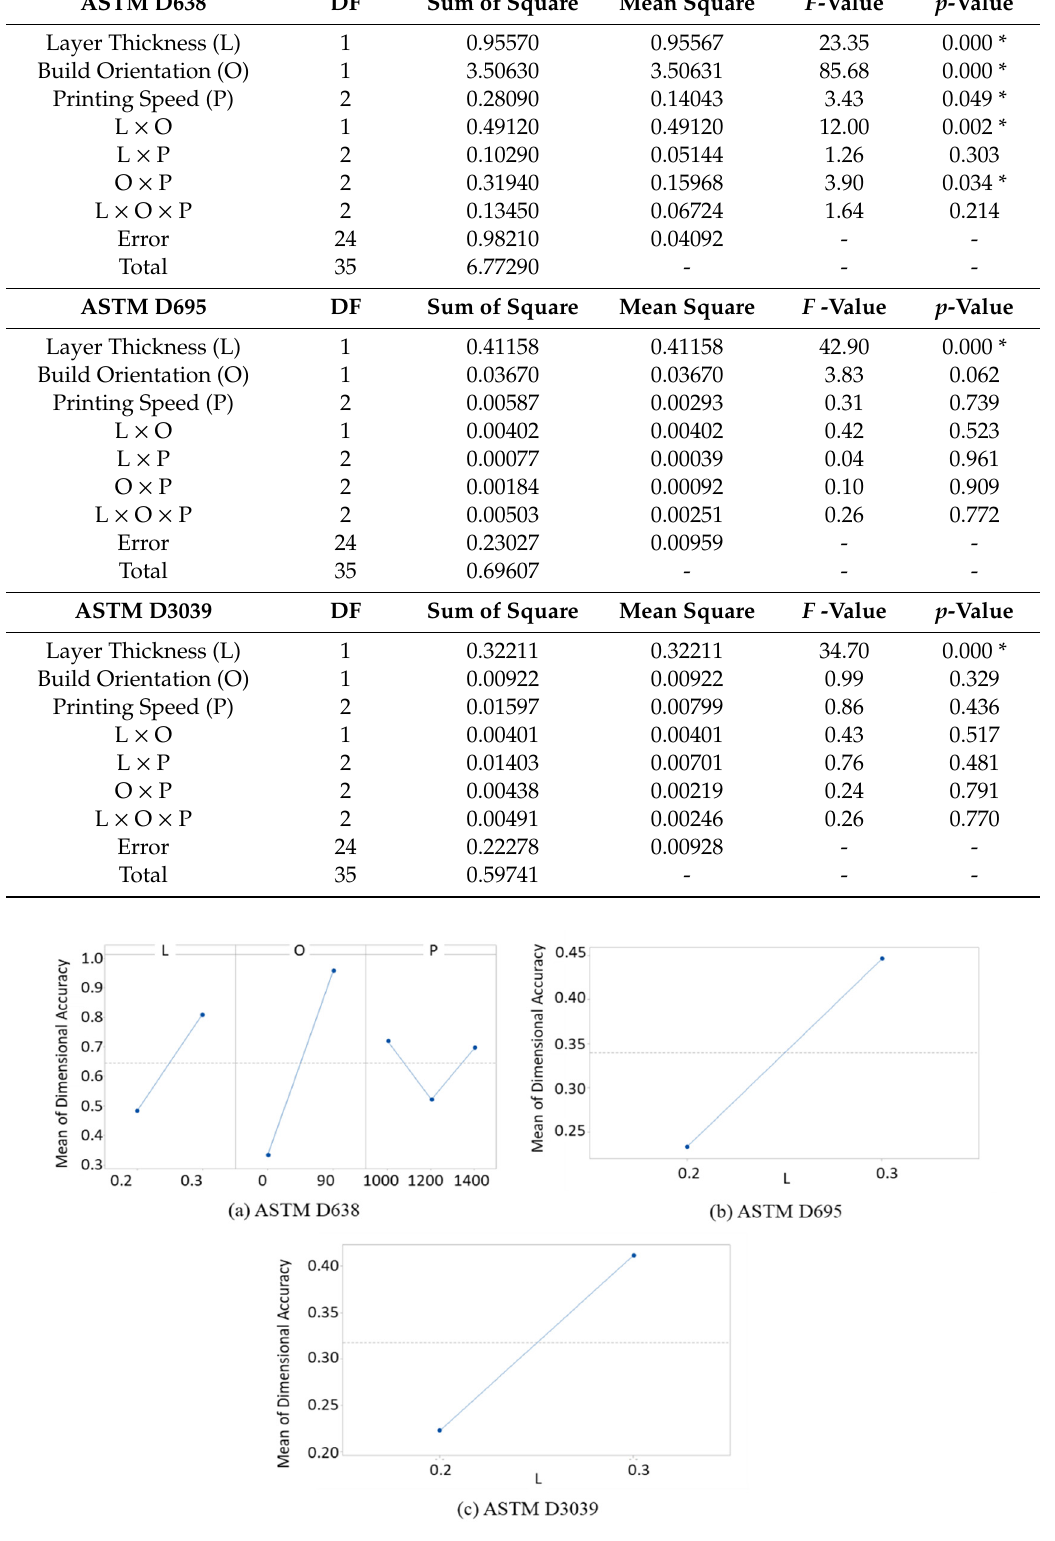
Figure 8. Interaction effect plots of the significant factors for the dimensional accuracy of ASTM D638. Based on the above main interaction effects, it can be inferred that layer thickness is a critical factor that is closely related to dimensional accuracy regardless of the sample designs. The fact that the 0.2 mm layer thickness always offers lower dimensional error values in the experiments supports that the decrease in layer thickness can result in more sophisticated fabrication. In addition, a plausible explanation for the impact of build orientation in the ASTM D638 case can be found in the design characteristic of the fabricated part. If the build orientation becomes 90°, the ASTM D638 design has a bridge form that needs support structures for proper fabrication (see Figure 9). Since support structures were not created for the experiments to eliminate the possible impacts of support structure generation on the performance measurements, poor dimensional accuracy always occurs in the bridge structure of the ASTM D638 design at the 90° build orientation. However, the default printing speed (1200 mm/min), which is the recommended printing speed for CFR-PEEK from the